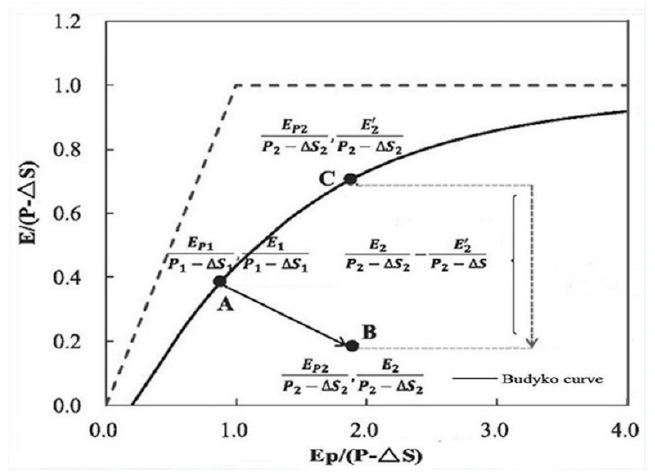
Figure 3. Schematic of the decomposition method for quantifying the climatic and anthropic factors on runoff.